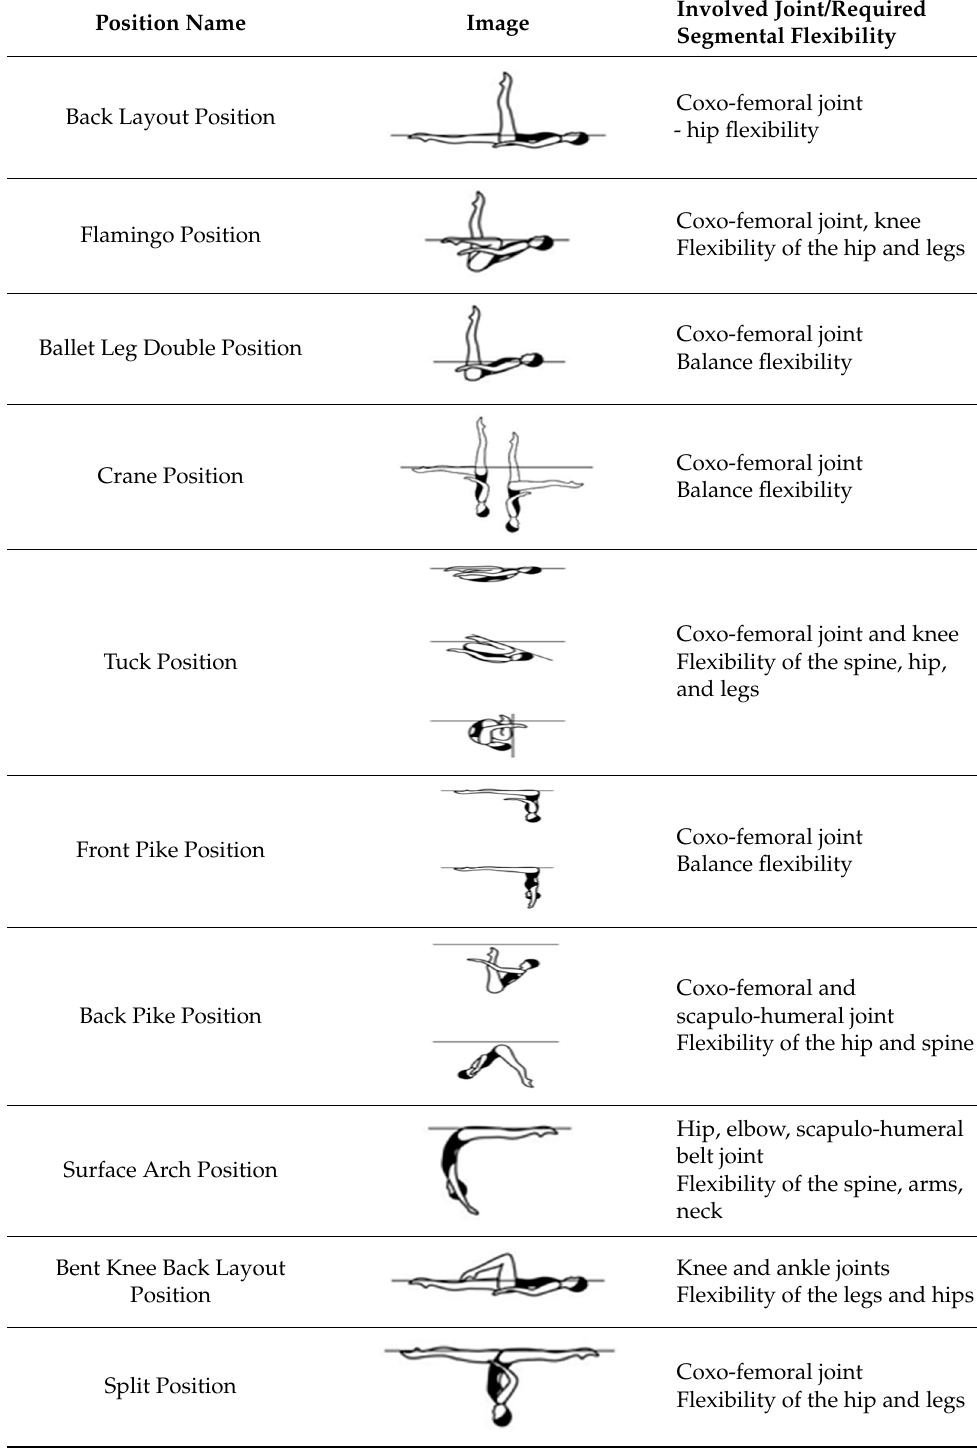
Table 1. Correspondence between the movements performed, the joints involved in the movement, and the required segmental flexibility.